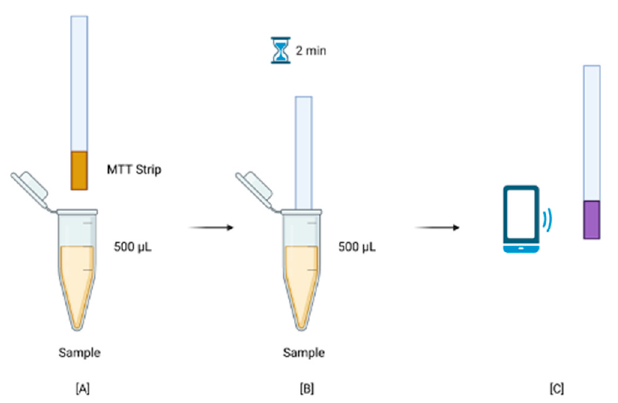
Figure 5. MTT-PMS test strip data collection procedure: ( A ) Preparation of bacteria suspension in a sample tube; ( B ) Submersion of MTT test strips for 2 min; ( C ) Recording of RGB colorimetric data using a smartphone camera. Created with BioRender.com (https://app.biorender.com/). Last accessed on 10 November 2021.